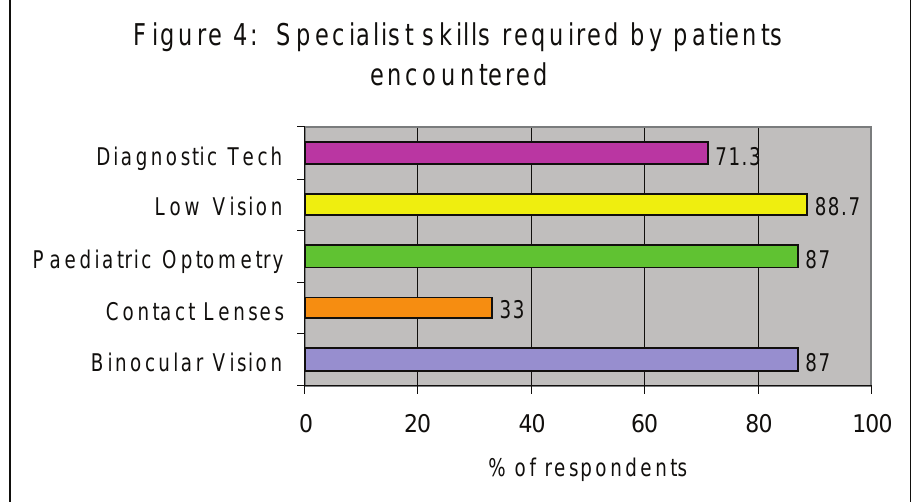
Figure 3: Im provem ent in clinical skills